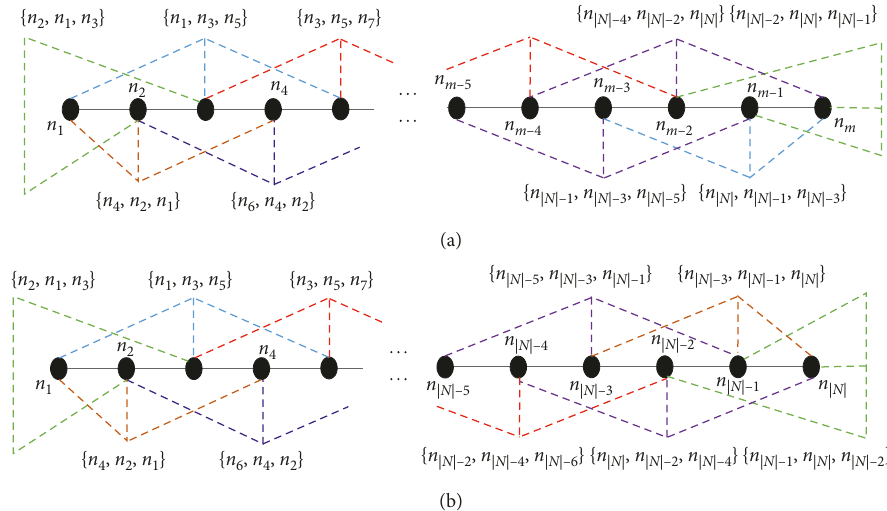
Figure 2: Dividing all nodes into groups for the comparison of bargain proposals. (a) The division of groups when the number of nodes | N | is odd. (b) The division of groups when the number of nodes | N | is